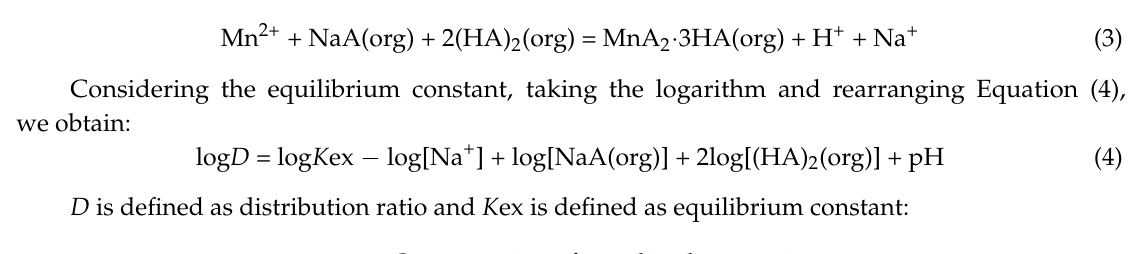
Table 3. Metal concentration of leachate by reductive leaching and pH controlled liquor (mg/L) (1 M H 2 SO 4 , 10 vol % H 2 O 2 , a reaction temperature of 60 °C, an agitation speed of 250 rpm, a solid/liquid ratio of 100 g/L, and a reaction time of 2 h).